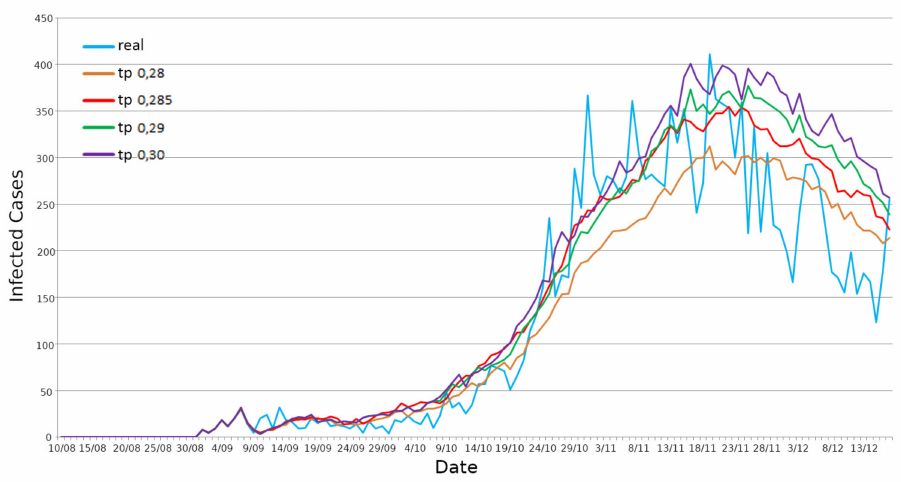
Figure 8. Graph of daily infected persons with different TP values—Reggio Emilia province.